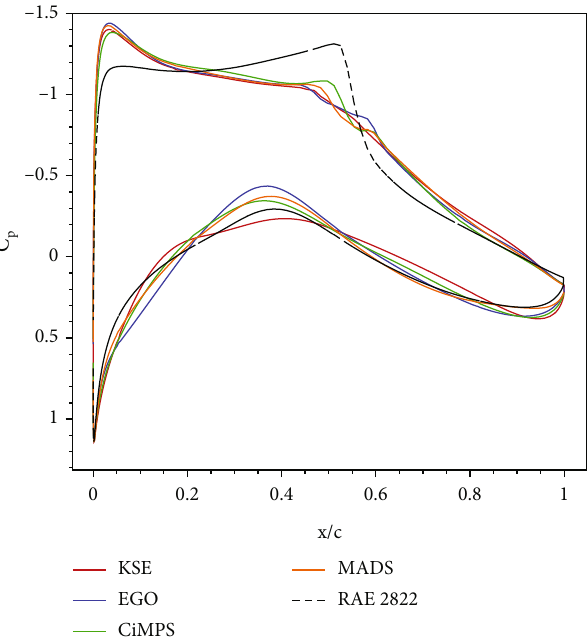
Figure 18: The comparison of pressure coe ffi cient